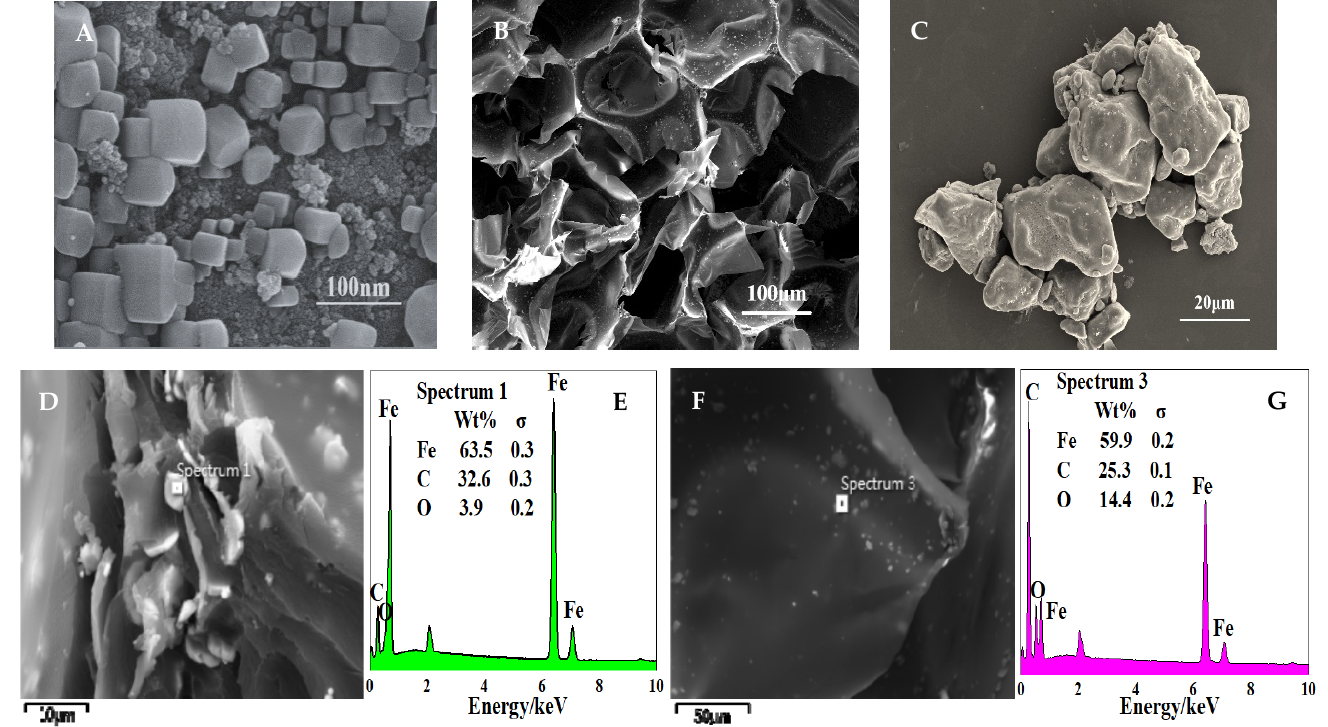
Figure 3. SEM and EDS spectra of the Fe 3 O 4 , mBPUF, and its powders. ( A ) Fe 3 O 4 ; ( B , D , F ) mBPUF; ( C ) mBPUF powder; ( E , G ) EDS spectrum of ( D , F ).